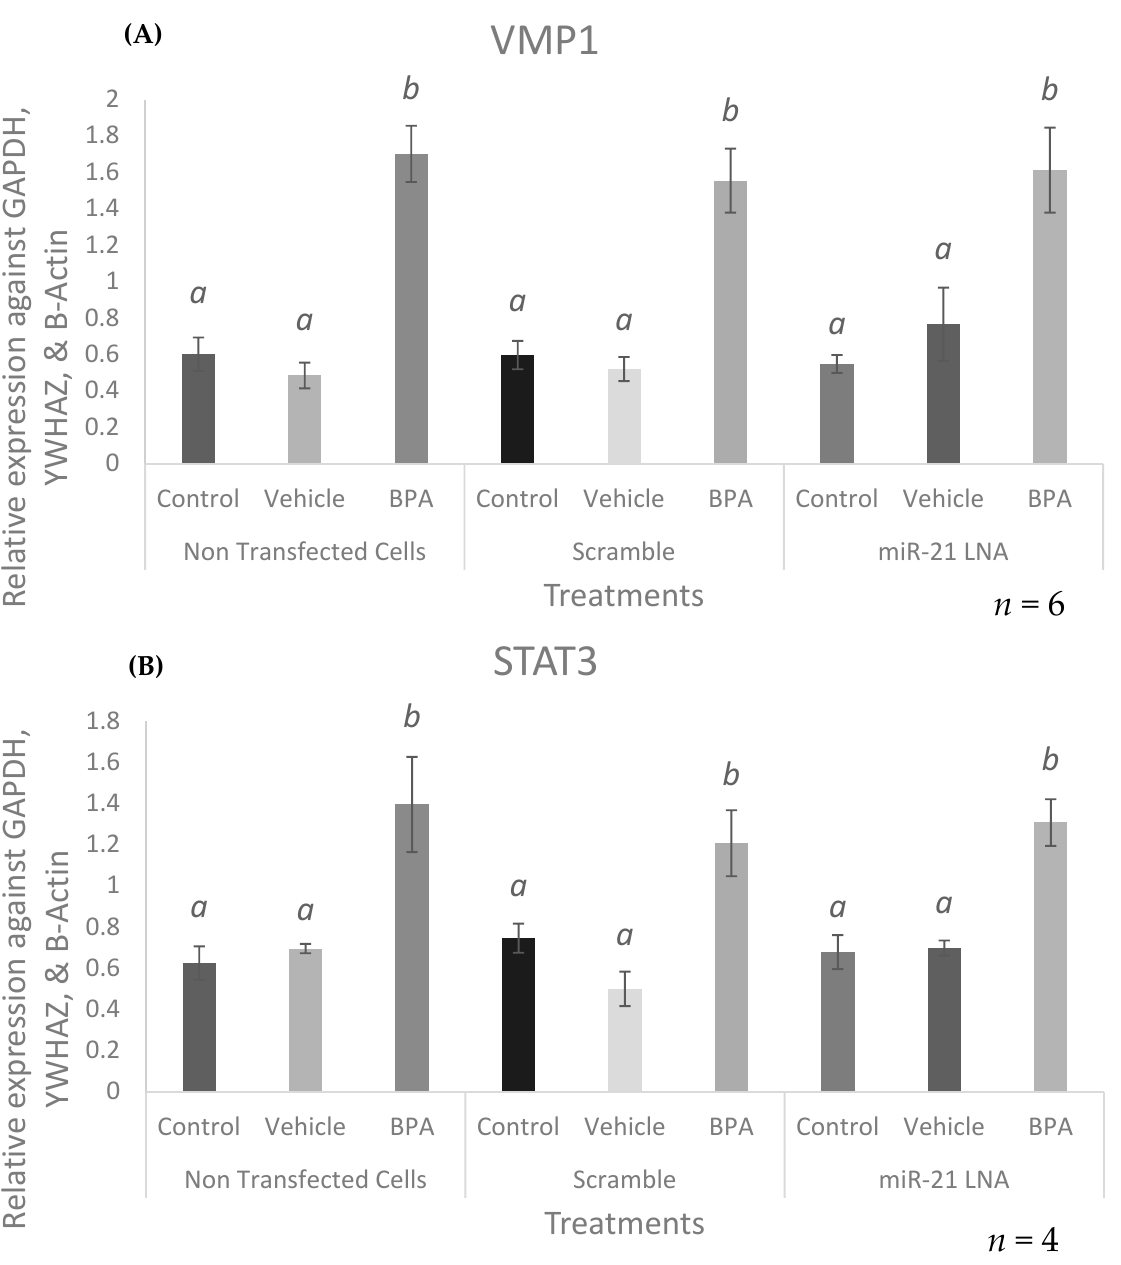
Figure 10. mRNA expression of modulators upstream of miR-21 transcription . Cells were trans- fected with LNA probes at 0.5 µ M for 12 h then treated with BPA for another 12 h. Upstream miR-21 regulators, VMP1 ( A ), and STAT3 ( B ) were upregulated after BPA treatment. Quantification is relative to reference genes GAPDH, YWHAZ, and B-Actin. Different letters indicate significant differences, with b indicating a significantly different mean than a at p < 0.05. Bars represent the mean ± SEM.